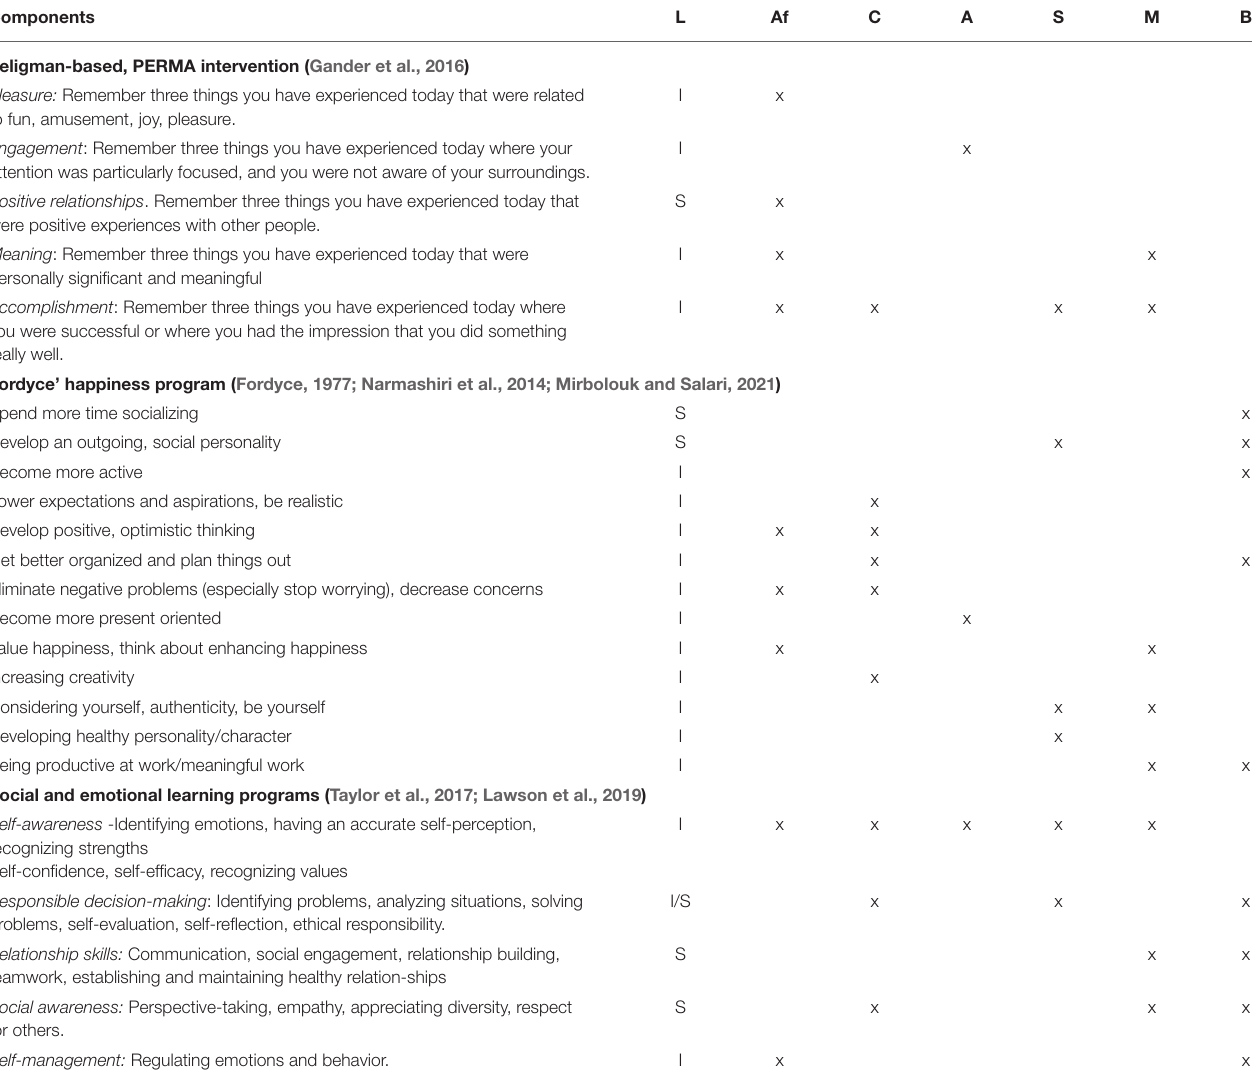
TABLE 3 | Hypothesized processes in three multi-component, positive psychology interventions. Components L Af C A S M